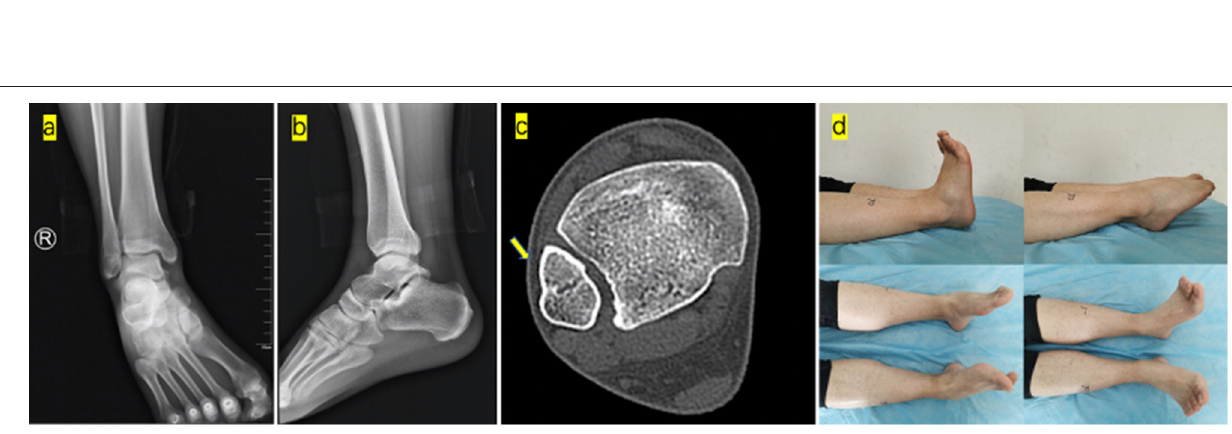
FIGURE 3 | Anteroposterior (a) and lateral (b) radiographs of the right ankle at 30 months of follow-up showed normal alignment of the ankle. CT axial scans (c) show the normal syndesmosis (yellow arrow). The general images of ankle range of motion (dorsiflexion and plantarflexion) and subtalar joint range of motion showed no difference compared to the left ankle (d)